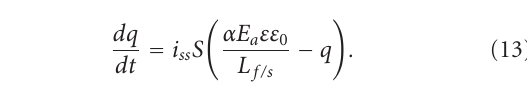
Inserting this in (11) results in the expression [19,